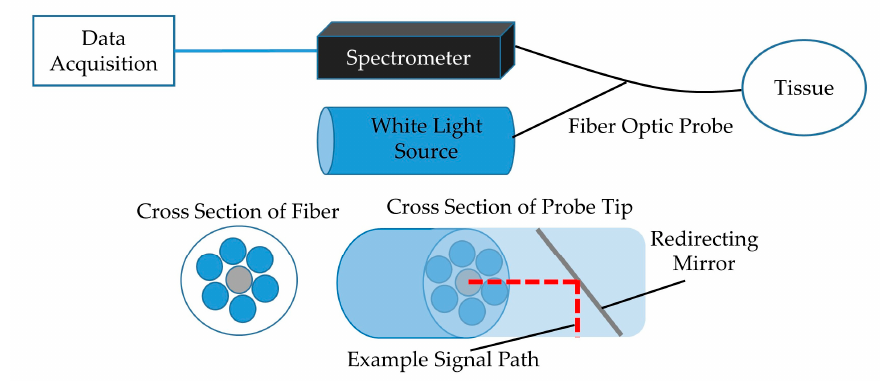
Figure 1. Block diagram of the experimental setup showing data acquisition module and light source connected to fiber optic probe. Cross-section of fiber with emitting and receiving fibers and tip showing mirror with 90° signal redirection included (adapted from previous publication [11]).